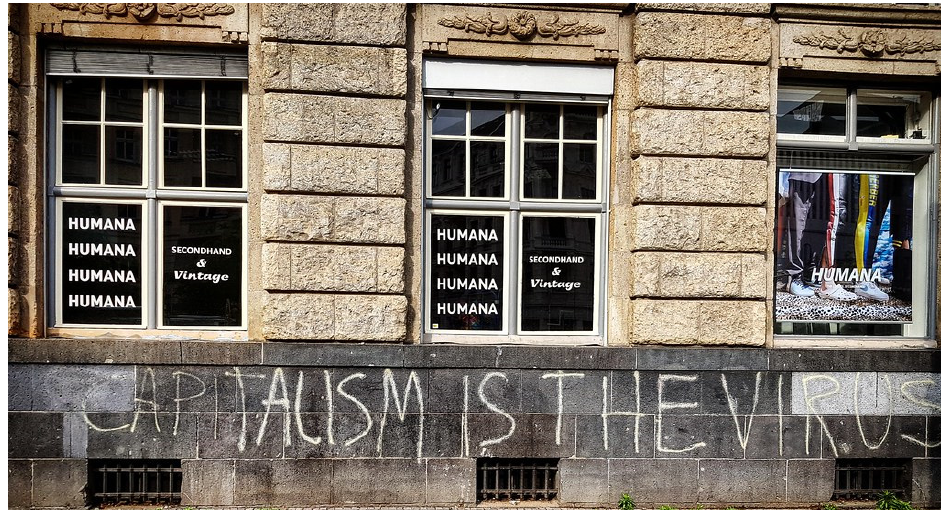
Figure 6. Anti-Capitalist Graffiti. Graffiti that frames Capitalism as the “virus”—written on the Humana Secondhand & Vintage Shop in the Neukölln neighborhood of Berlin (Source: https://www.flickr.com/photos/elhamalawy/49849794112/, accessed on 24 August 2021).